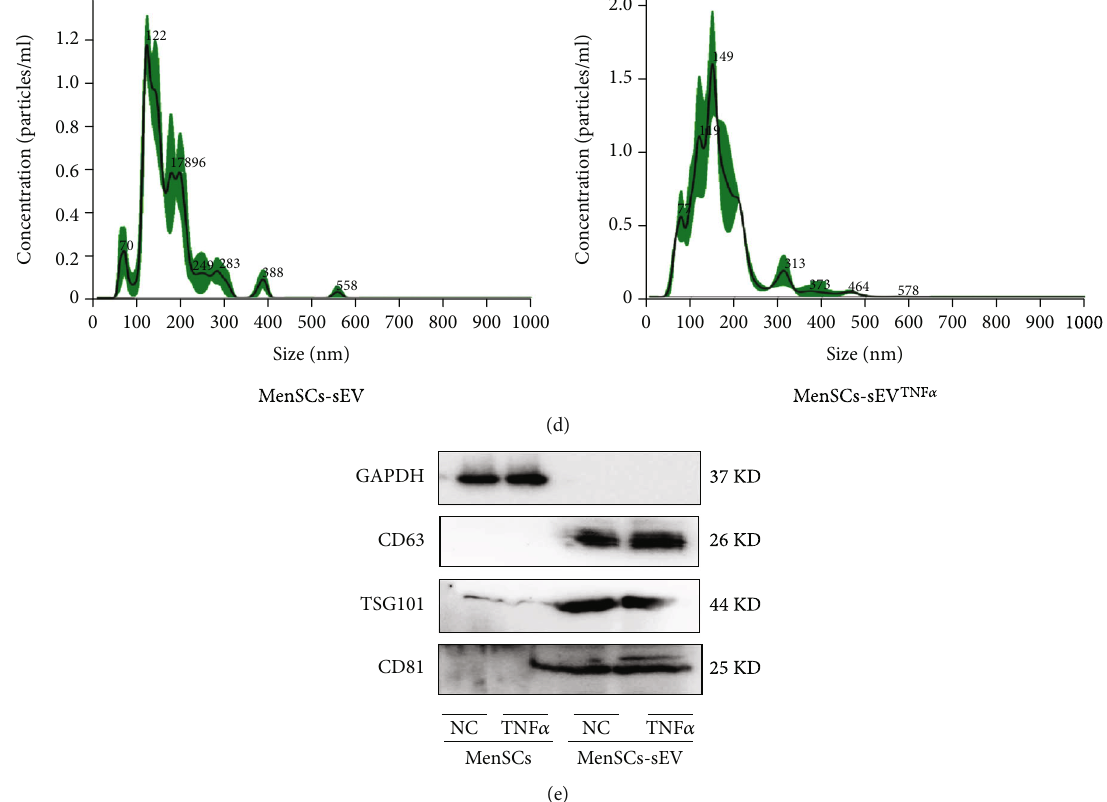
Figure 1: The characterization of MenSCs and MenSC-derived small EVs. (a) The expression of MenSC surface molecules was detected by fl ow cytometry. Among them, IgG1 antibody is the isotype control of CD29, CD34, CD45, CD73, CD90, CD105, and CD117, and IgG2a is the isotype control of HLA-DR. (b) Optical images of the trilineage di ff erentiation staining and morphology of MenSCs. (c) Transmission electron micrographs of small EVs. (d) Nanoparticle tracking analysis (NTA) of MenSCs-sEV and MenSCs-sEV TNF- α . (e) Western blotting was used to measure the expression of CD63, TSG101, and CD81 molecules on the surface of MenSCs and their small